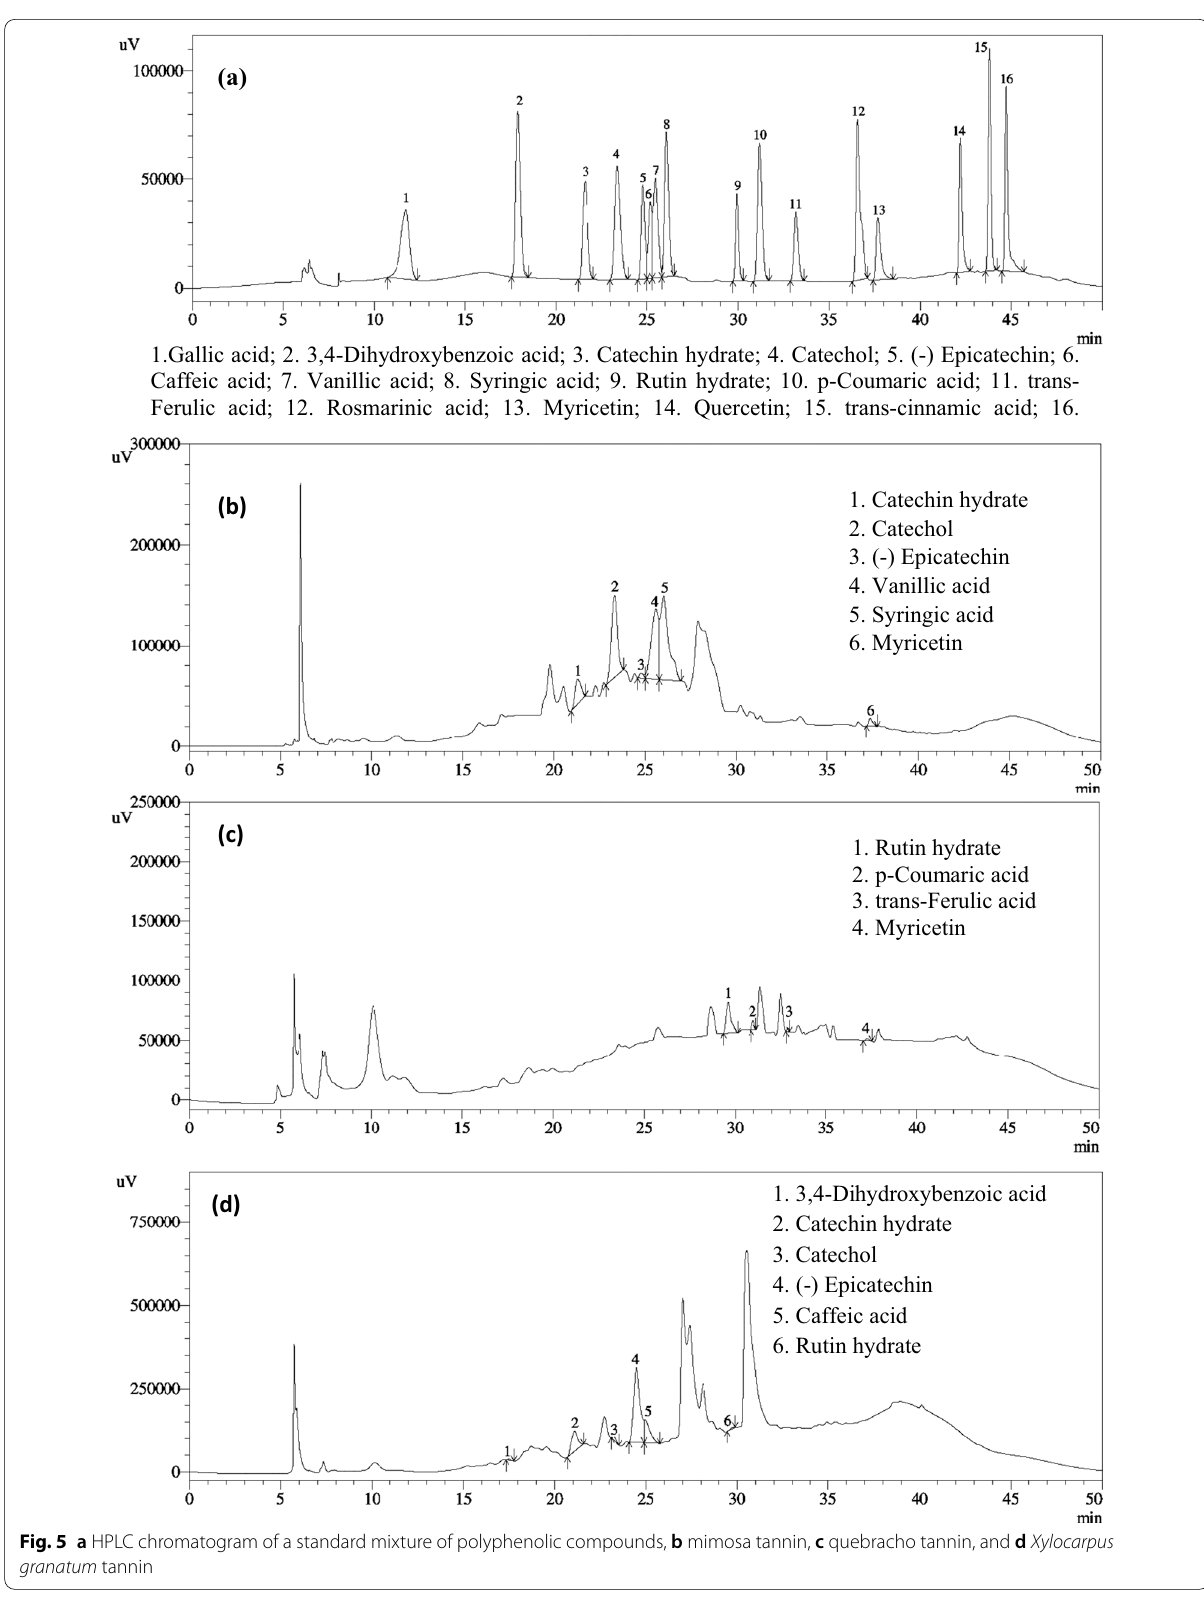
Fig. 5 a HPLC chromatogram of a standard mixture of polyphenolic compounds, b mimosa tannin, c quebracho tannin, and d Xylocarpus granatum